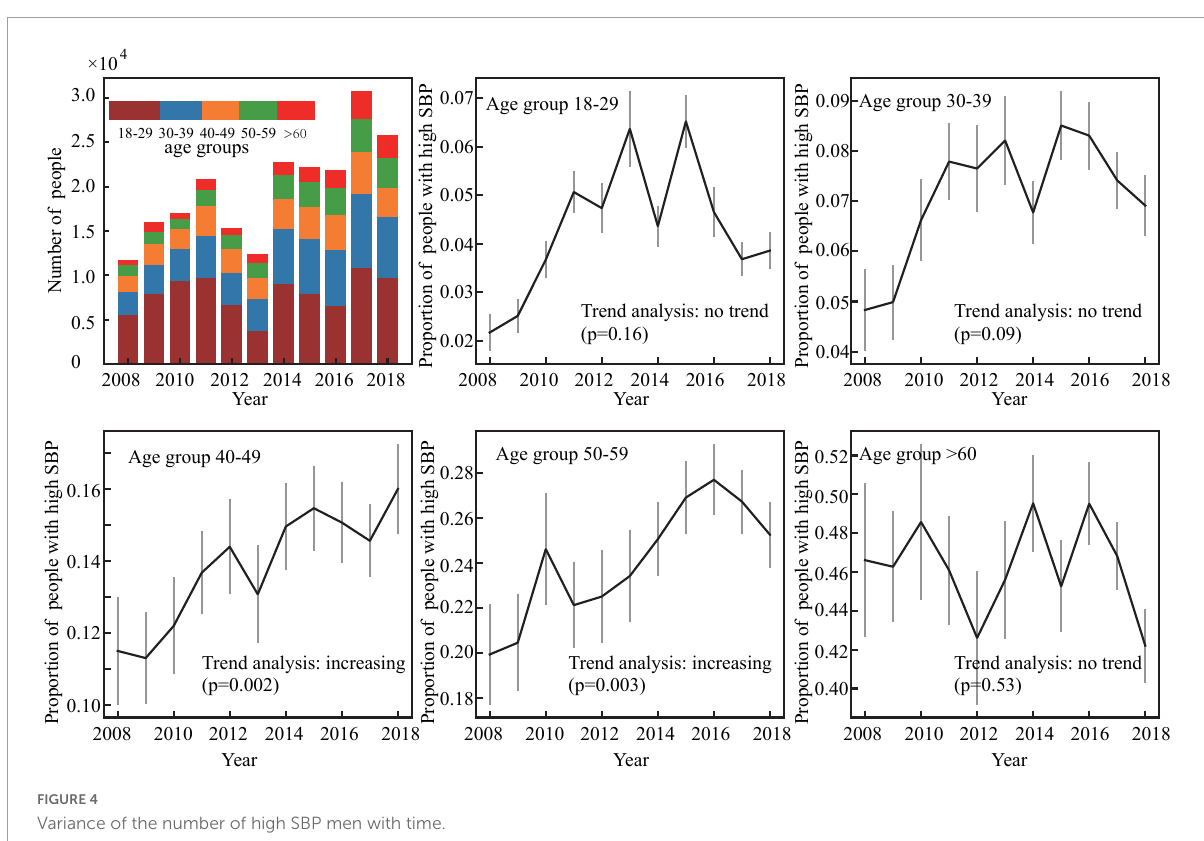
FIGURE4 Variance of the number of high SBP men with